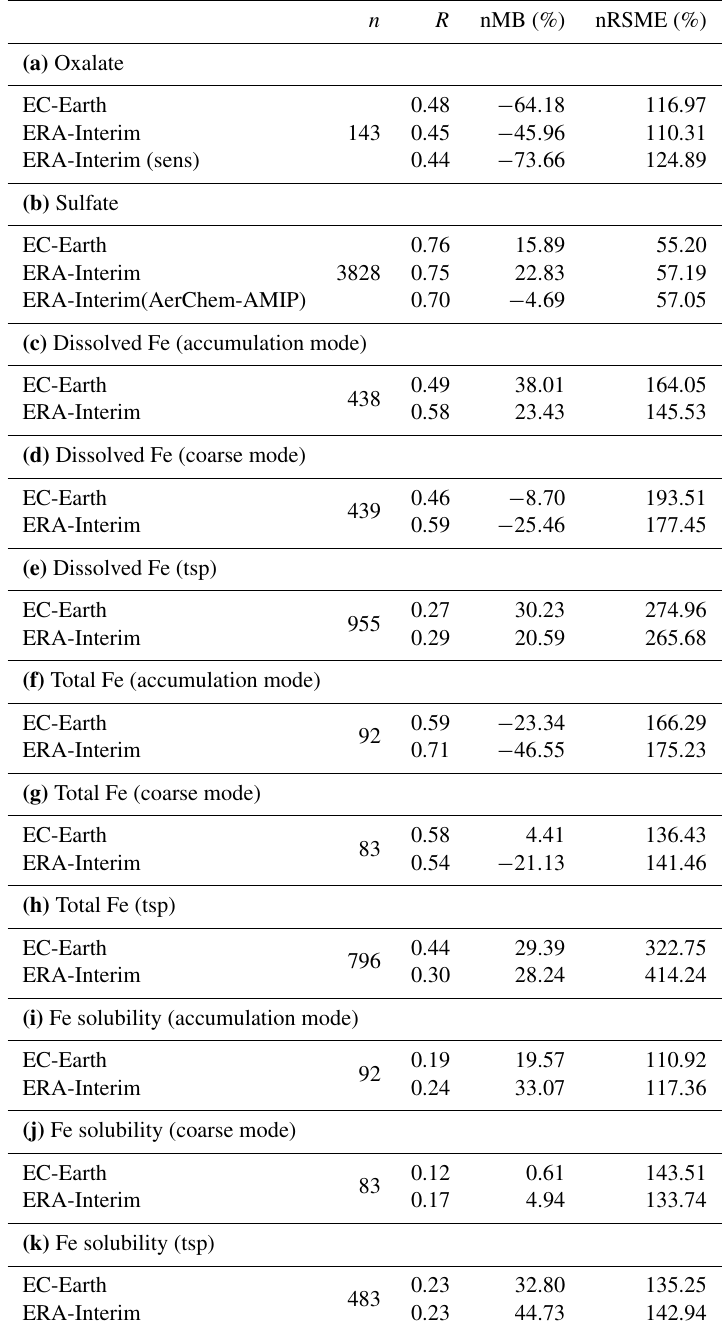
Table A2. Summary of statistics for the evaluation of the simulated concentrations (as depicted in Fig. 6) of (a) oxalate and (b) sulfate. Statistics are also given for (c) , (d) , (e) the dissolved Fe-containing aerosols,; (f) , (g) , (h) the total Fe-containing aerosols; and (i) , (j) , (k) the derived aerosol solubility (SFe = %DFe/TFe) for (c) , (f) , (i) the accumulation mode; (d) , (g) , (j) the coarse mode; and (e) , (h) , (k) the total suspended particles (tsp), respectively. The number of stations ( n ), the Pearson correlation coefficients ( R ) between the simulated and the measured concentrations, the normalized mean bias (nMB) and the normalized root-mean-square errors (nRMSEs) are indicated for the EC-Earth and ERA-Interim simulation. The results for the sensitivity simulation EC-Earth(sens) for oxalate evaluation, as well as the EC-Earth(AerChem-AMIP) for the sulfate evaluation, are also shown.